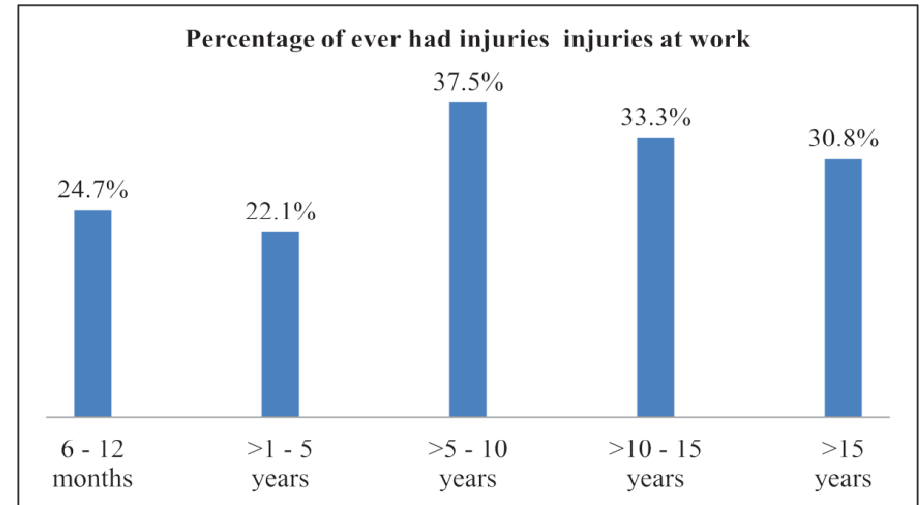
Figure 3. Injuries and years of experience: Percentage of injuries according to experience in ASGM